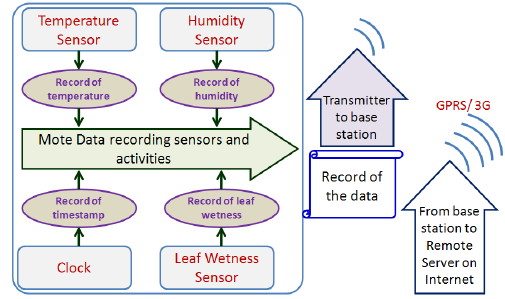
Figure 2. Sensor process model